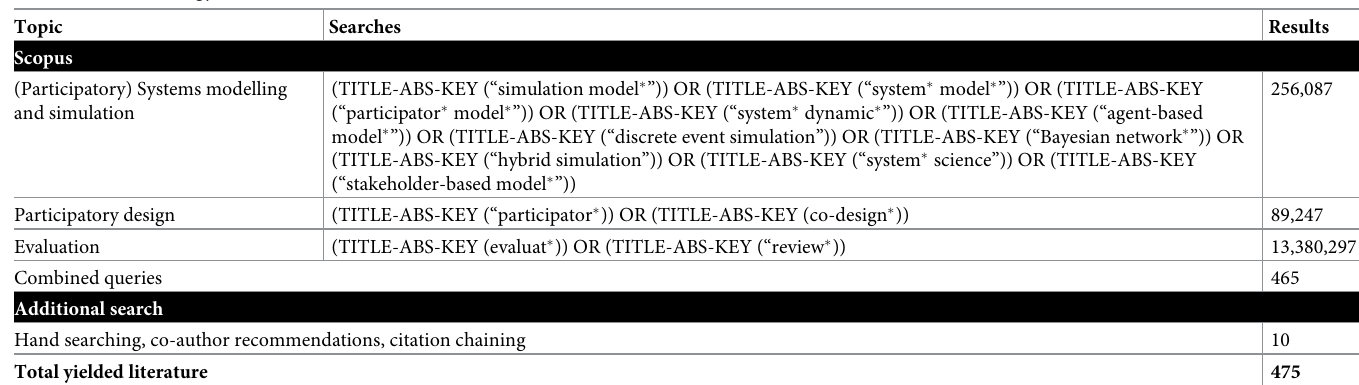
Table 1. Search strategy.